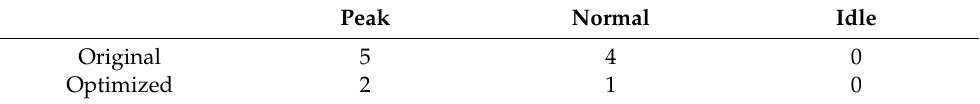
Table 7. Comparison of conflict numbers before and after optimization in three